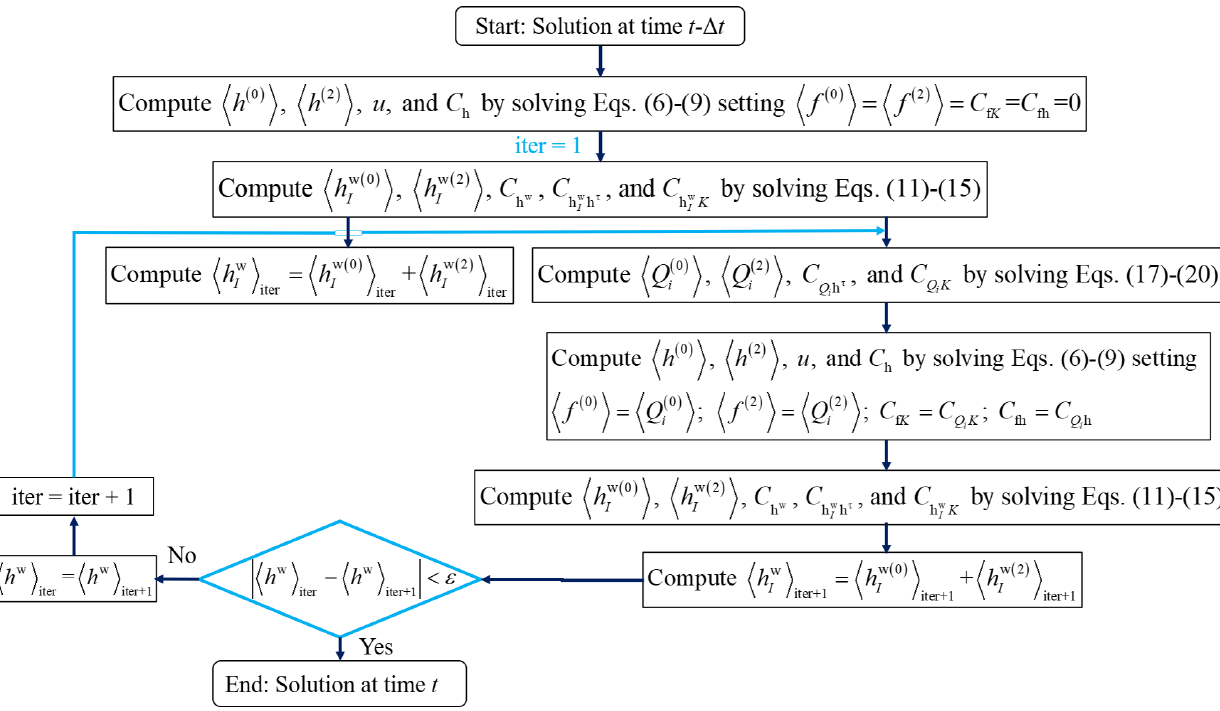
Figure 2. Workflow for the numerical solution of MEs within time interval [ t – (cid:49)t , t ] when flux between monitoring wells and the aquifer is